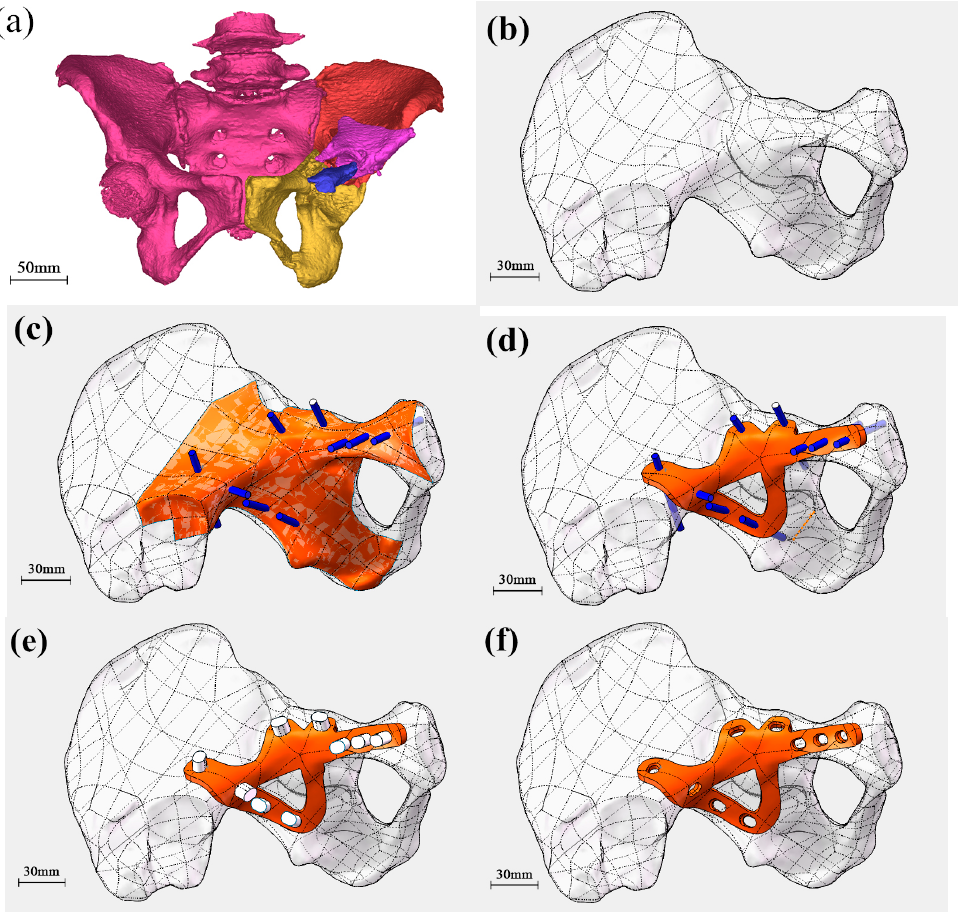
Figure 1. Key procedures in designing customized bone plate: ( a ) CT data model of pelvis; ( b ) Generation of pelvic model; ( c ) Fabrication of the initial shape; ( d ) Determination of the shape and thickness of the bone plate; ( e ) Modeling of the screw holes; and ( f ) The final bone plate model.